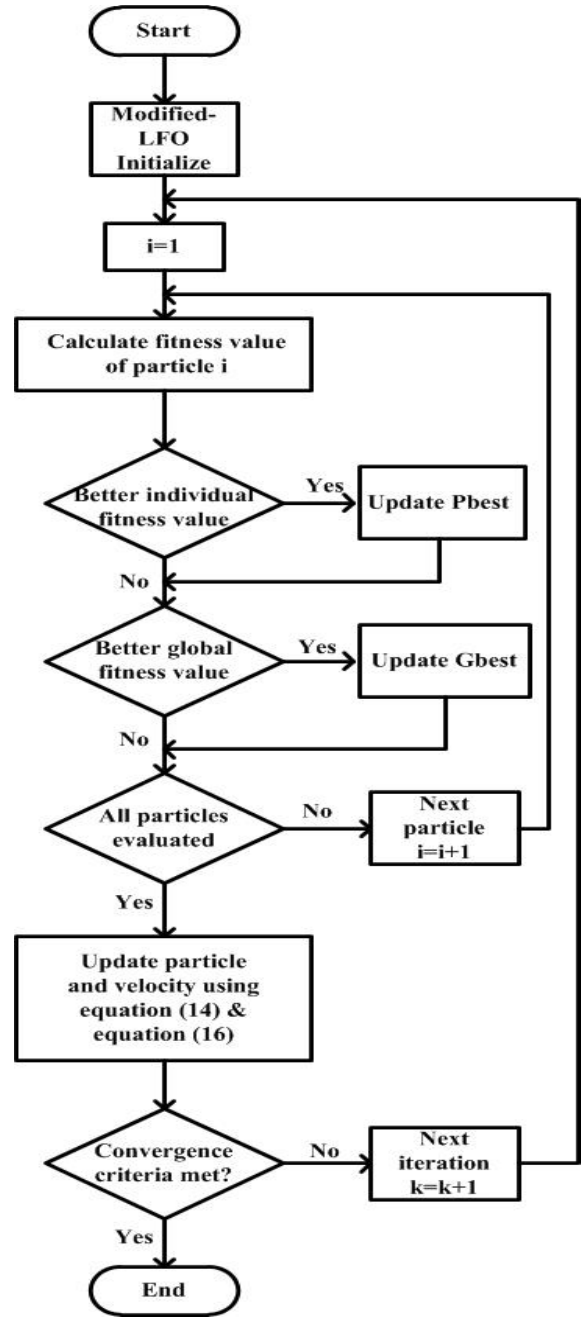
Figure 5. Modified Levy flight optimization.